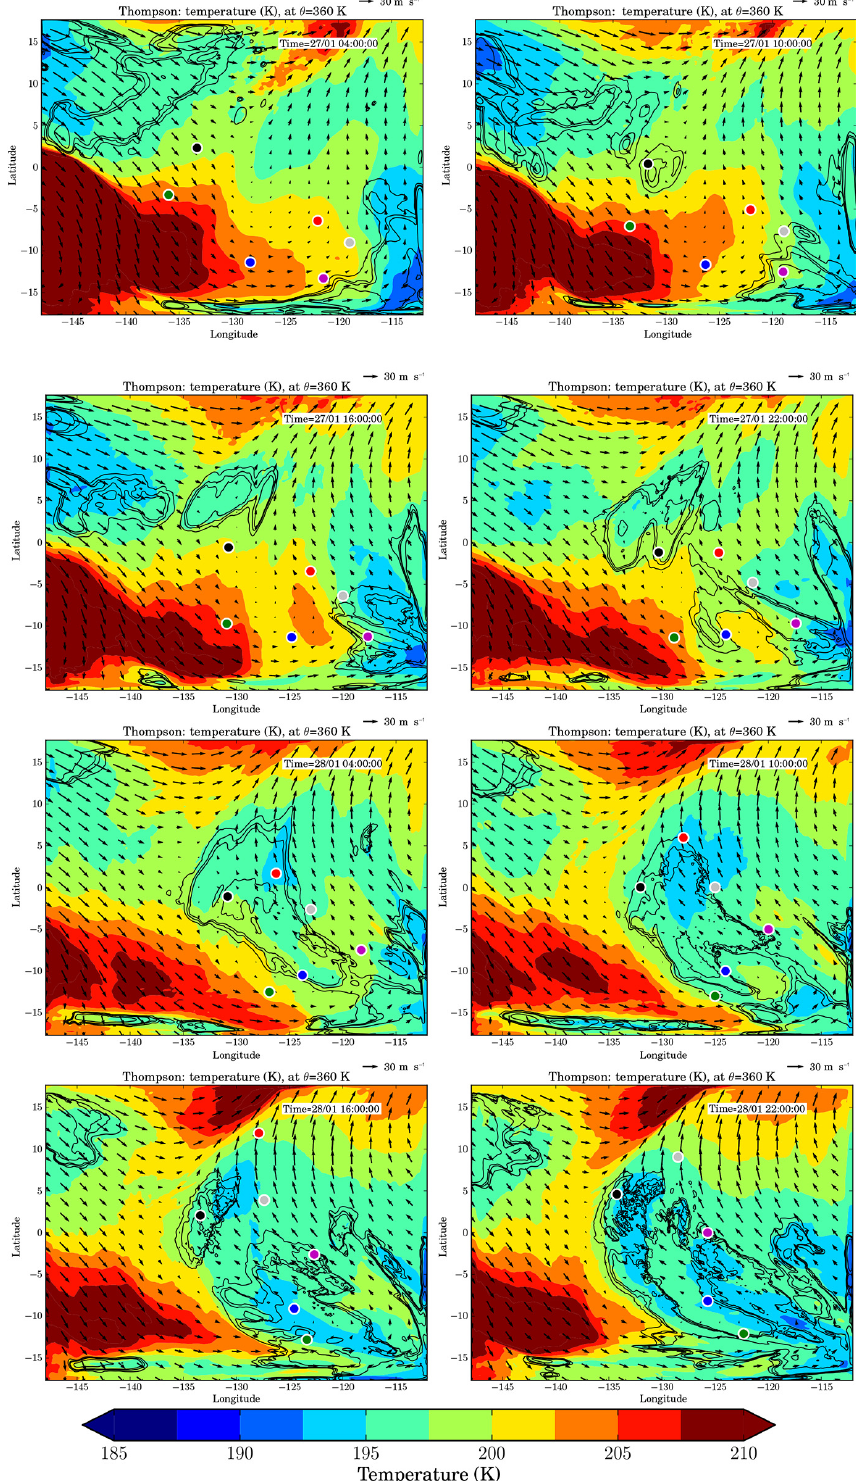
Figure 2. Successive maps of temperature at the potential temperature level θ = 360 K for the reference simulation. The black contours correspond to contours of ice water content of 1 × 10 − 8 , 5 × 10 − 8 , 1 × 10 − 8 and 5 × 10 − 8 kgkg − 1 respectively. They delimit the cirrus. The colour points represent the position of air parcels surrounding the cirrus on 28 January at 10:00UTC; they were launched (backward and forward) at that date on the isentrope θ = 360 K, at the horizontal positions shown by the colour points. They follow individual 3-D air-parcel trajectories and illustrate the air displacement in the region. The vectors represent the horizontal winds. Atmos. Chem. Phys., 16, 3881–3902, 2016